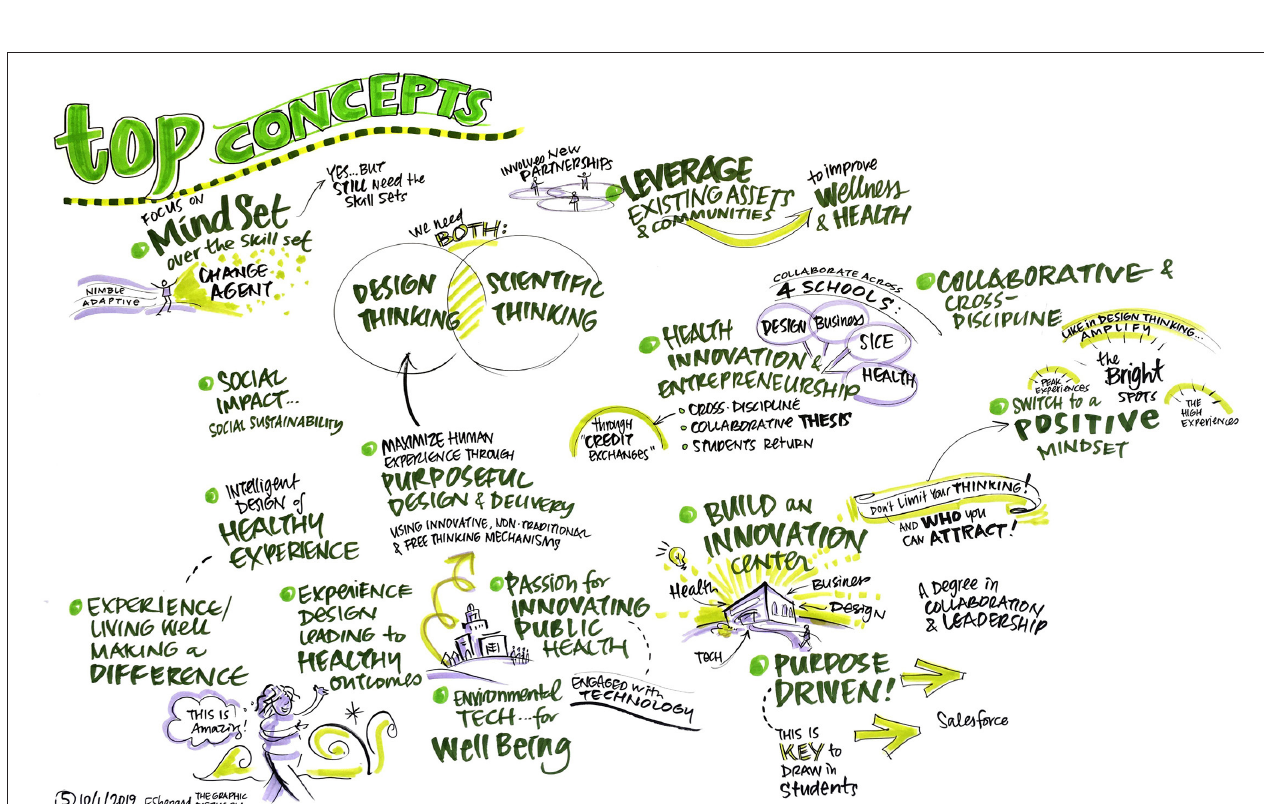
FIGURE 2 | What concepts do we need to focus on for our new department to be successful?